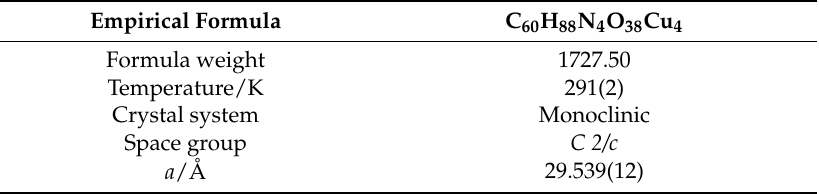
Table 3. Crystallographic data and structure refinements for 1